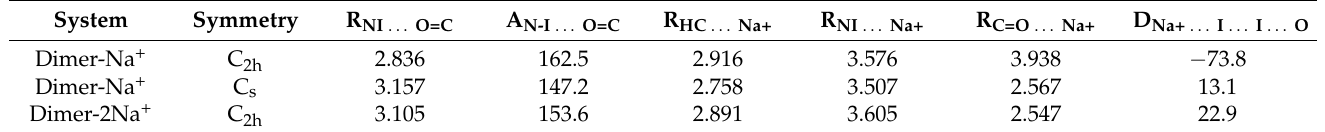
Table 3. Relevant geometrical parameters for Na + binding by the cyclic dimer of the model sys-